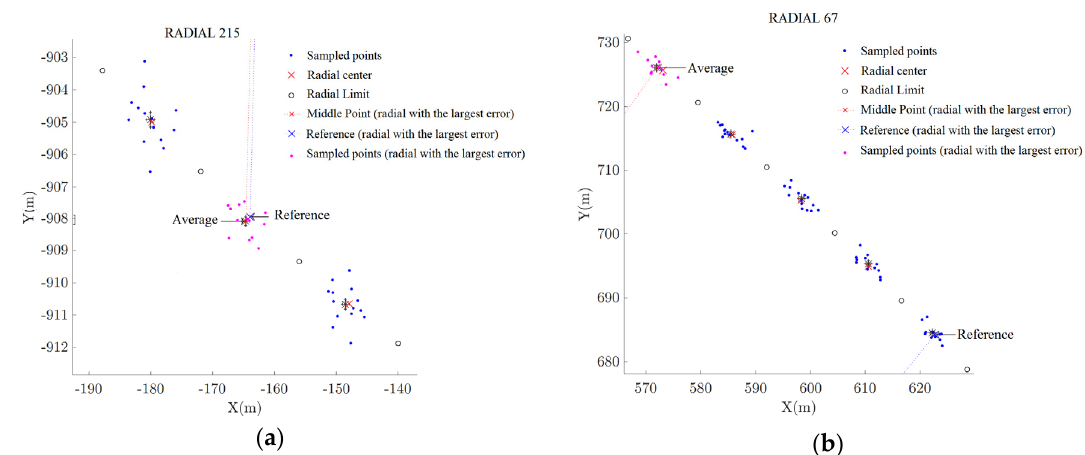
Figure 11. VOR inspection using the developed HIL platform: ( a ) Test 2 ; ( b ) Test 3 .